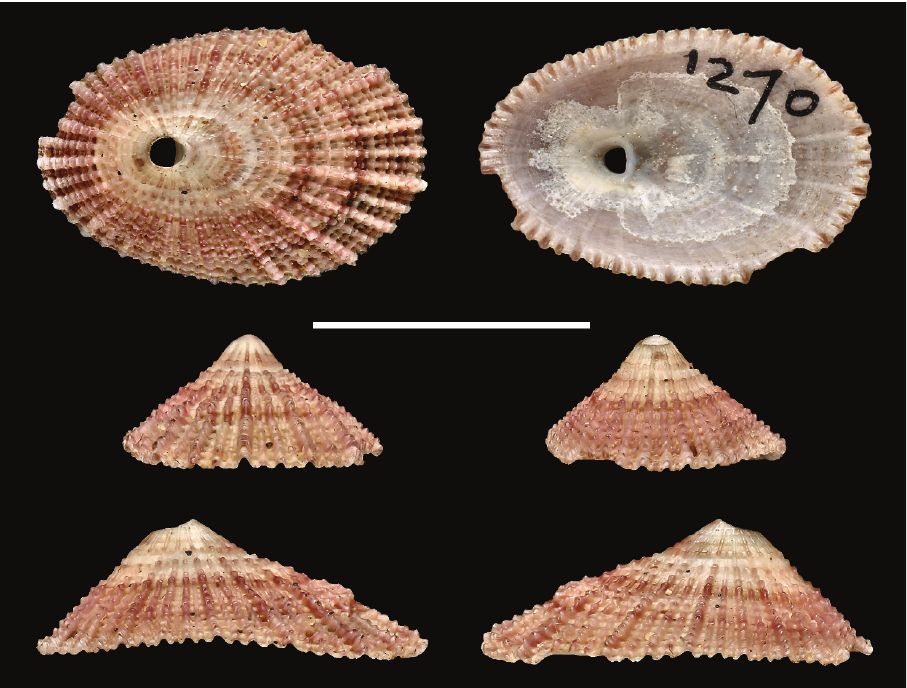
Figure 3. Glyphis fuscocrenulata E.A. Smith, 1906. Syntype T524/NMSA-MOL 001270. Scale bar: 10 mm.